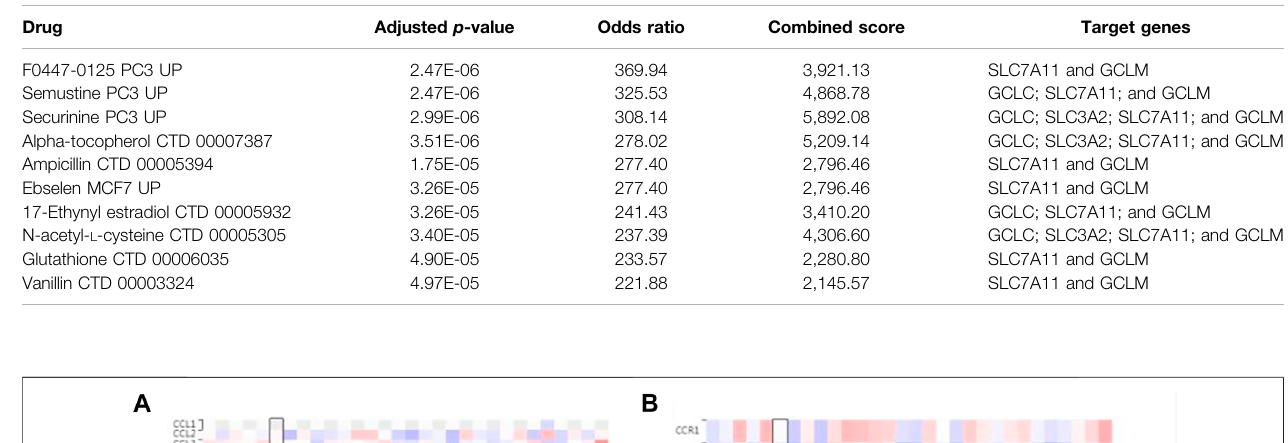
TABLE 3 | Potential drugs that regulate action for both SLC7A11 and co-expression genes.